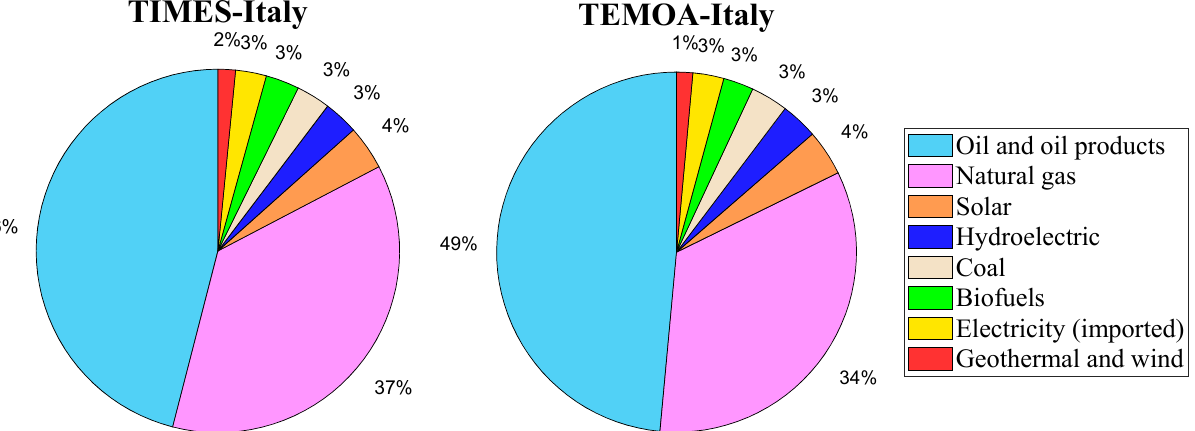
Figure 4. Comparison of the optimal overall energy mixes in 2030.